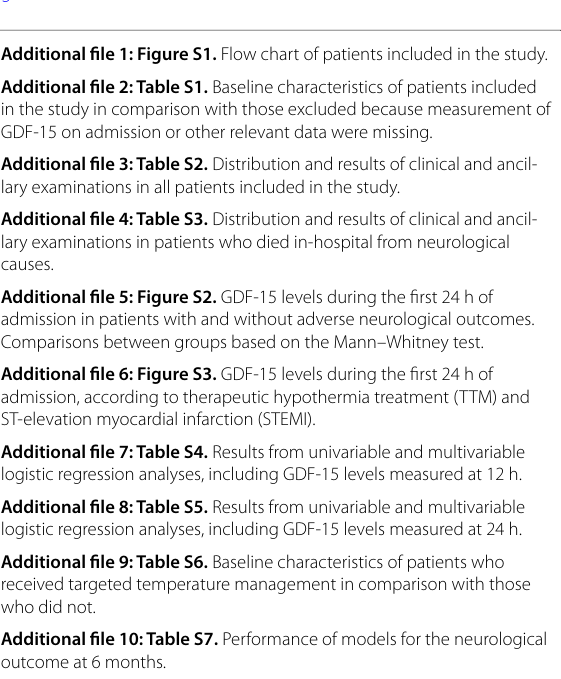
Additional file 10: Table S7. Performance of models for the neurological outcome at 6